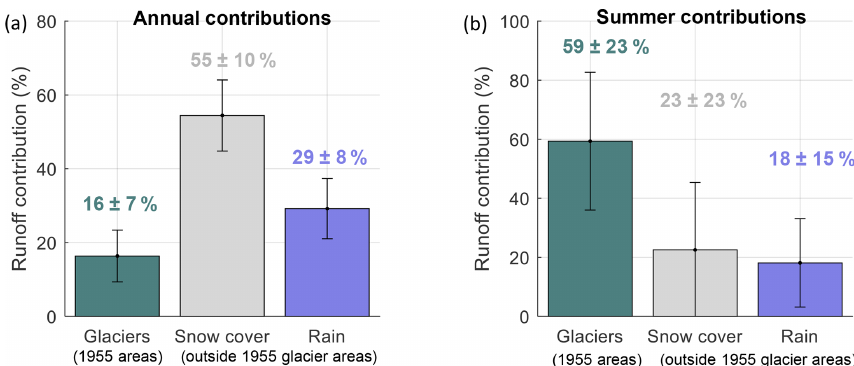
Figure 8. Partition of runoff contribution in the Maipo River basin in the period 1955–2016. The contributions are computed for the headwater regions defined by the 1955 glacierized areas (the sum of ice melt, snow melt, and rain) and snow melt and rain outside those areas. The plus and minus symbols refer to the interannual variability. (a) Annual and (b) summer contributions are given.